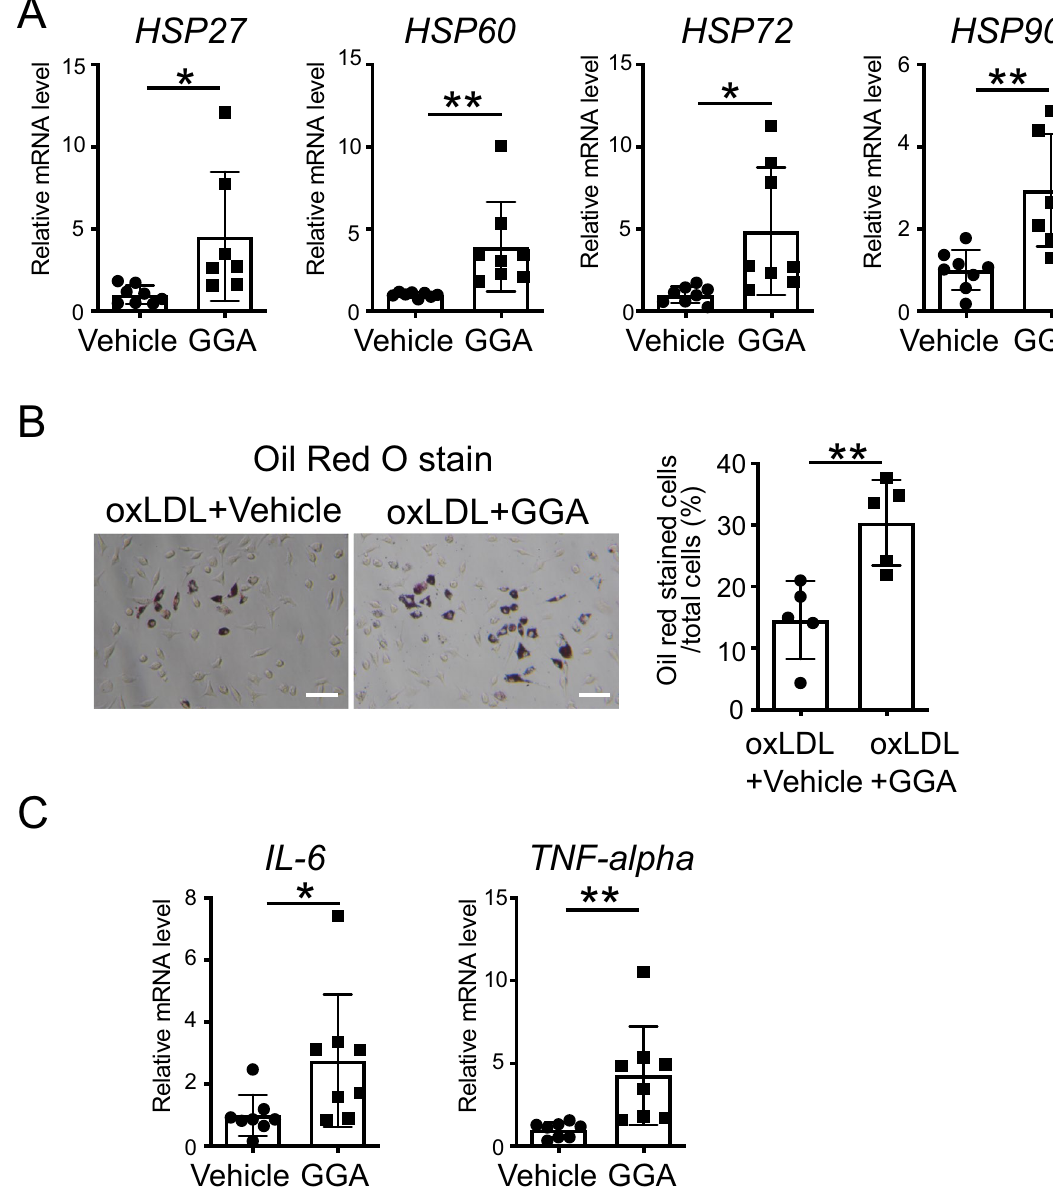
Figure 5. Effect of the induction of heat shock proteins (HSPs) on peritoneal macrophages. ( A ) HSP27 , 60 , 72 , and 90 mRNA expression levels in ApoE −/− peritoneal macrophages after geranylgeranylacetone (GGA) treatment. Peritoneal macrophages were isolated from 8-week-old ApoE −/− mice. After the cells were treated with vehicle or GGA (10 μM) for 24 h, total RNA was extracted. ( B ) Representative micrographs of Oil Red O staining of peritoneal macrophages (left). Scale bar = 100 µm. Vehicle or GGA (10 μM) was added to the cells, and oxidized low-density lipoproteins (oxLDL) (100 μg/mL) were administered 24 h later. One day later, the cells were fixed and stained. Bar graph quantifying Oil Red O positive cells in peritoneal macrophages (right). ( C ) Interleukin 6 ( IL-6 ) and tumor necrosis factor-alpha ( TNF-alpha ) mRNA expression levels in ApoE −/− peritoneal macrophages after GGA treatment. Peritoneal macrophages were isolated from 8-week-old ApoE −/− mice. After the cells were treated with vehicle or GGA (10 μM) for 24 h, total RNA was extracted. Each bar represents the mean ± standard deviation (SD). Significant differences are marked on the chart (*p < 0.05; **p < 0.01). n = 5–8 per